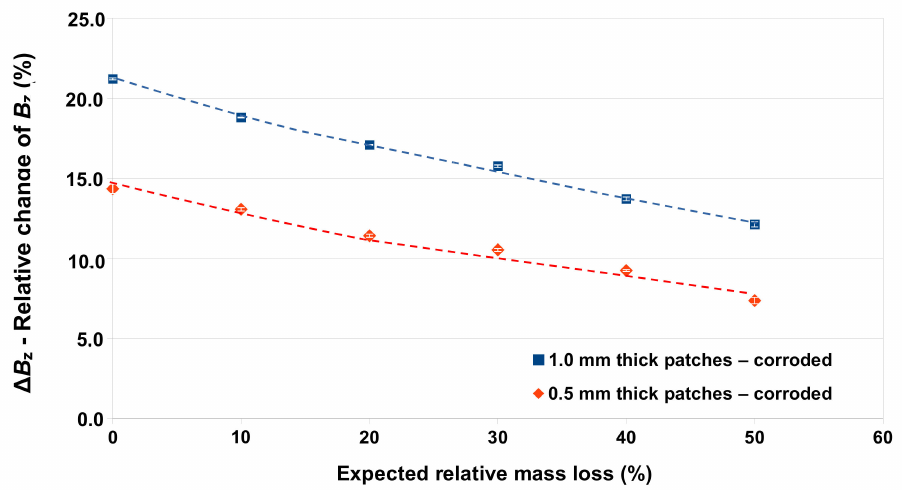
Figure 14. Relative change of B z , measured from the 3D-magnetometer, as a function of the relative mass loss of patches.